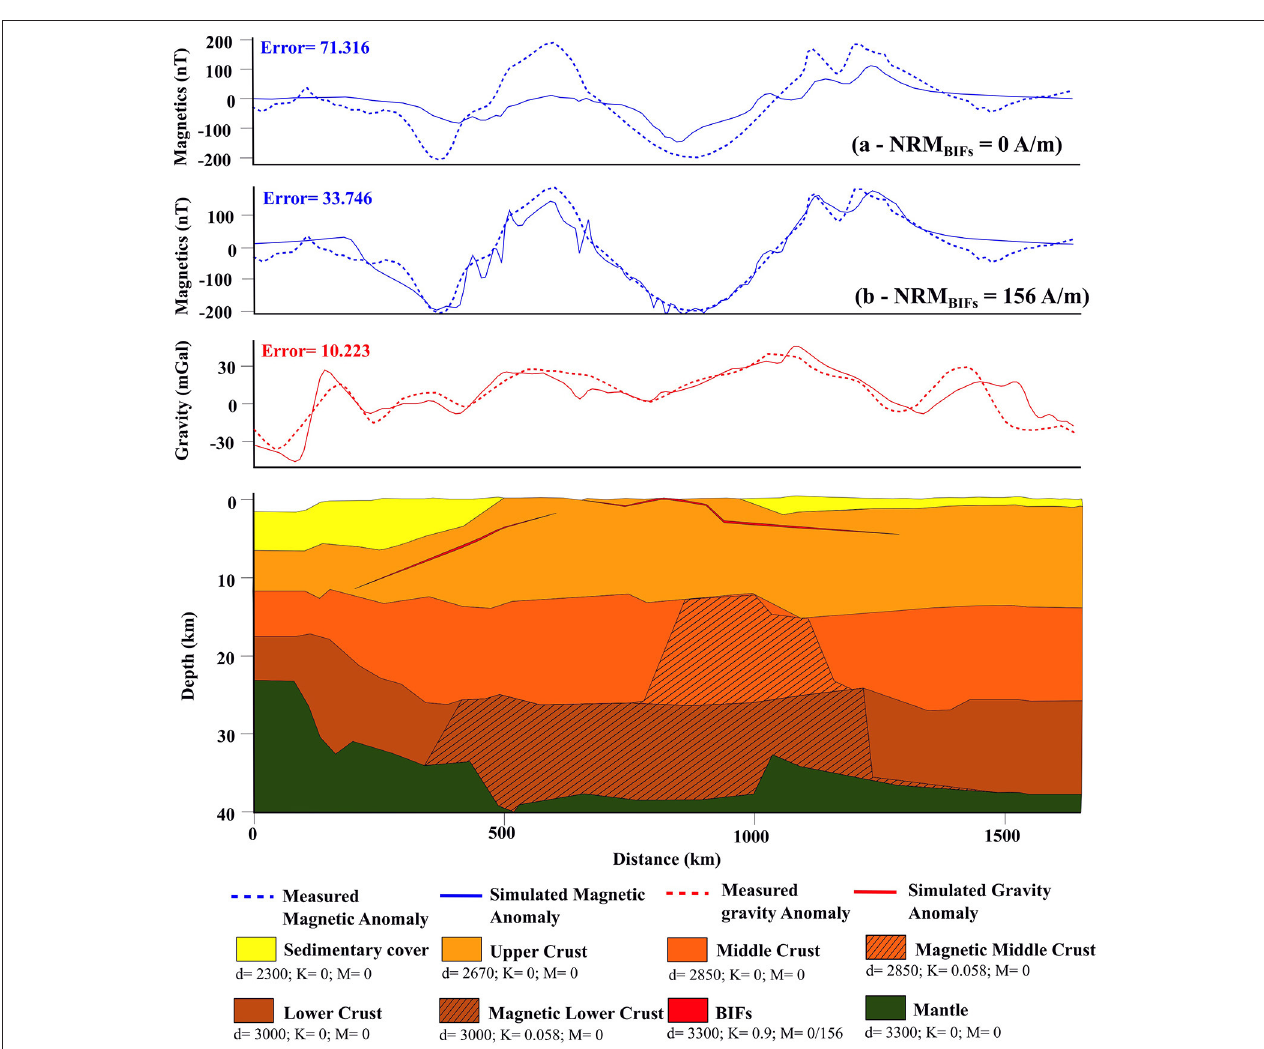
FIGURE 8 | Two possible simulation results for a model of the crustal structure along profile C beneath the WAMA, with induced magnetization only (a: M = 0 A/m) and adding remanence (b: M = 156 A/m). d, density (kg/m 3 ); K, Magnetic susceptibility (SI); M, Remanence intensity (A/m). Remanence Inclination and Declination are (I = 26.33 ◦ , D = − 4.37 ◦ ) and remain unchanged in following models. The origin of the profile is North-oriented. The fitted gravity anomaly remains unchanged in the following models. The error parameter shown in the magnetic and gravity anomaly profiles corresponds to the RMS value.